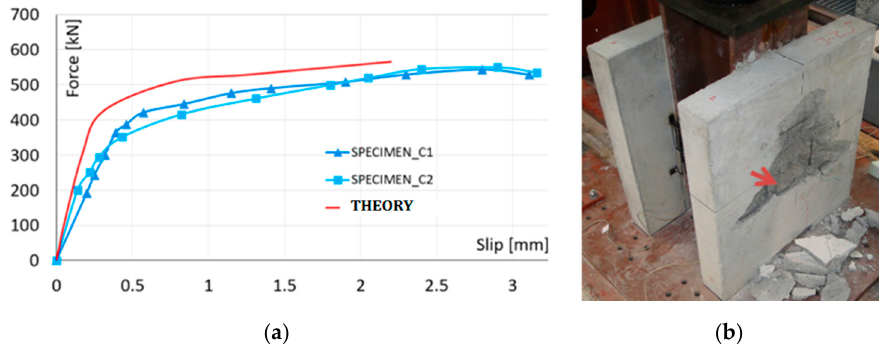
Figure 9. Load-slip curves of the ordinary concrete specimens ( a ) and failure mode ( b ).